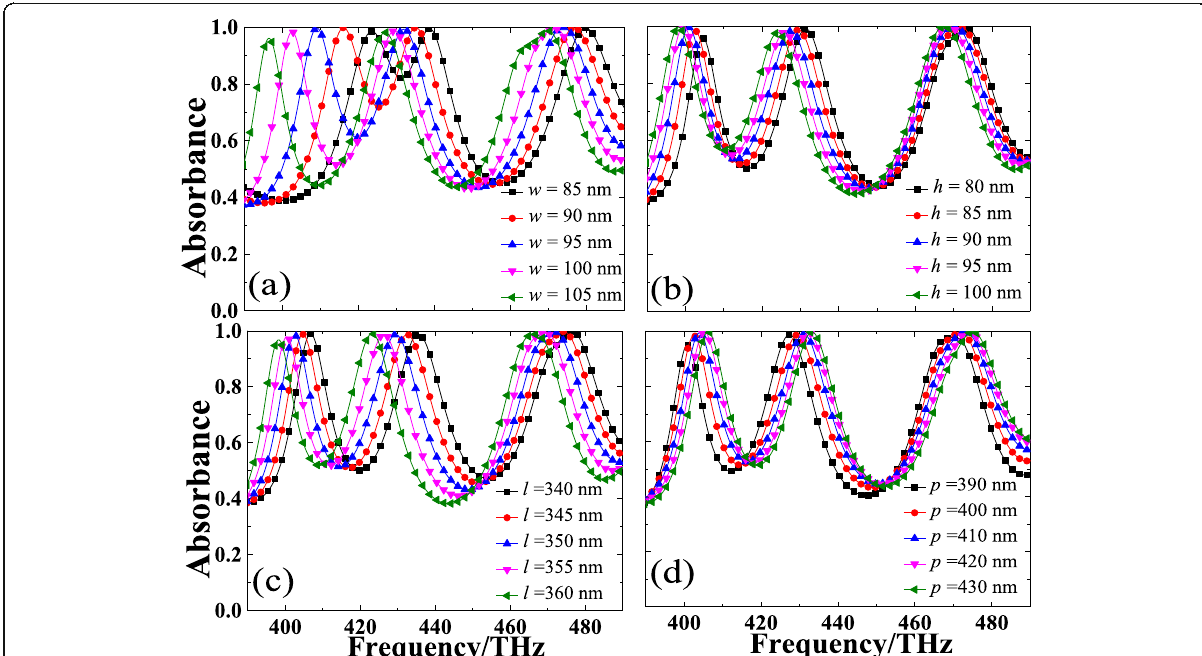
Fig. 5 The dependence of the perfect absorption on different geometric parameter of the proposed PLA. a – c Wire width ( w ), height ( h ), wire length ( l ) of the silicon cross nanostructure, and d periodicity ( p ) of the unit